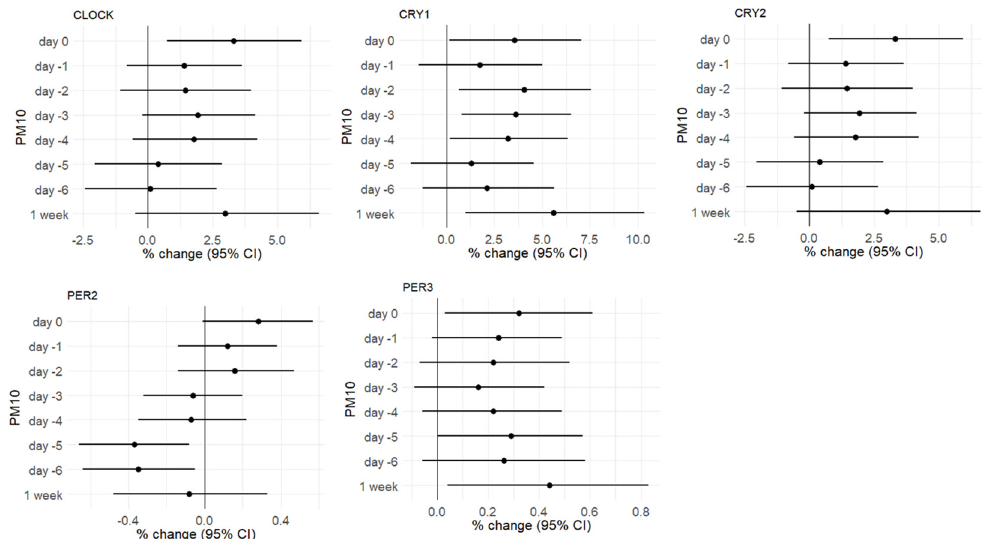
Figure 1. Plots showing the associations between short-term exposure to PM 10 and the methylation of CLOCK , CRY1 , CRY2 , PER2 , and PER3 genes from day 0 to day − 6 (single days and weekly average). Methylation values are provided as percentage changes (% changes) in methylation associated with 10-µg/m 3 increments, estimated by multivariable regression models adjusted for age, BMI, smoking habits, percentage of lymphocytes, Pyrosequencing run, CpG site, season, temperature, and humidity.